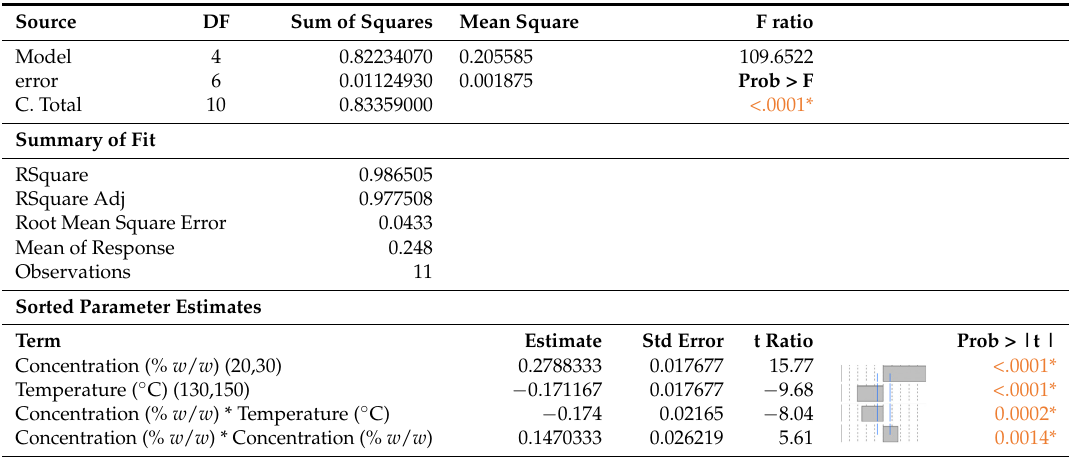
Table 6. Analysis of variance for response Abs at 680 nm (DoE2).